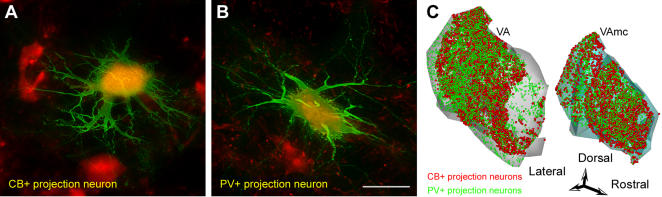
The two neurochemical classes of thalamo-cortical projection neurons in the ventral anterior nuclei labeled with CB or PV.Projection neurons were retrogradely labeled with a tracer (FE; green fluorescence), then immunohistochemically labeled in 300 µm sections for CB or PV (red fluorescence), and then microinjected to show the dendritic tree (LY or Alexa Fluor 488) resulting in yellow fluorescence. A, Intracellularly filled CB+ projection neuron. B, Intracellularly filled PV+ projection neuron. C, 3D-reconstruction of the topographical distribution of the population of CB+ (red) and PV+ (green) projection neurons in the ventral anterior nuclei. The neurons are intermingled in both nuclei. Scale bars: A-B, 50 µm; C, 1.5 mm.